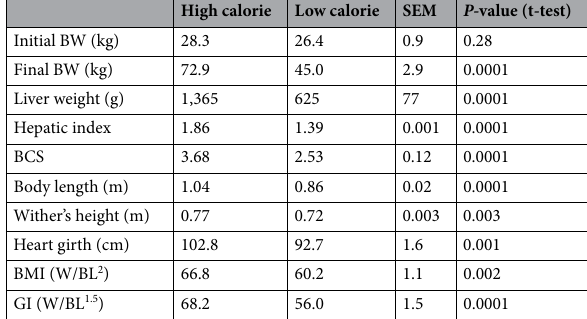
Table 4. Physical body parameters in the high- and low-calorie treatments. SEM: standard error of the mean; BW: body weight; Hepatic Index: (liver weight)*100/(body weight); BCS: body condition score; BMI: Body Mass Index; W: weight; BL: body length; GI: G